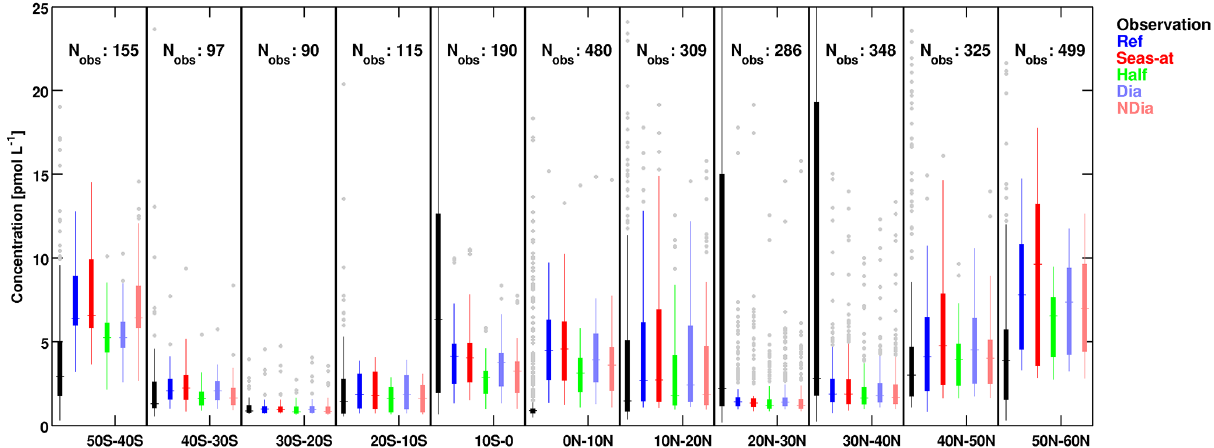
Figure 6. Box-and-whisker plot of simulated and observed surface ocean bromoform concentrations (pmolL − 1 ). Box widths are determined by the 25th and 75th percentiles of data within each 10 ◦ latitude box, outliers (grey) are located outside 1.5 times the differences of the percentiles, and the middle line of each box shows the median. Simulated concentrations are averaged over one grid cell around the location of observations. Different colours denote different experiments (Ref: blue; Seas-at: red; Half: green; Dia: pale purple; NDia: pale red); observations are shown in